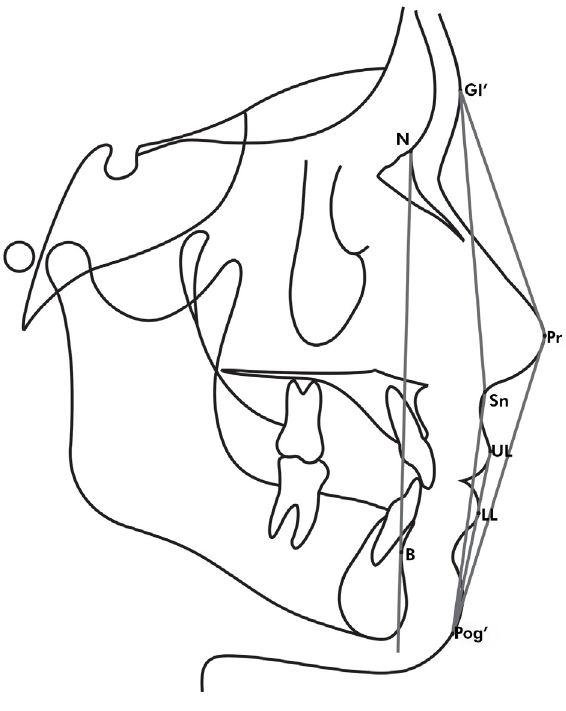
Figure 1. Less usual cephalometric variables: Gl’.Pr.Pog’ (°): Angle of total facial convexity including the nose, Gl’.Sn.Pog’ (°): Angle of facial convexity excluding the nose; N-B.Upper Lip-Pog’ (°): Holdaway’s soft tissue angle; Upper Lip-E(mm): Linear distance between the upper lip anterior point and line E (esthetic plane by Ricketts); Lower Lip-E (mm): Linear distance between the lower lip anterior point and line E.